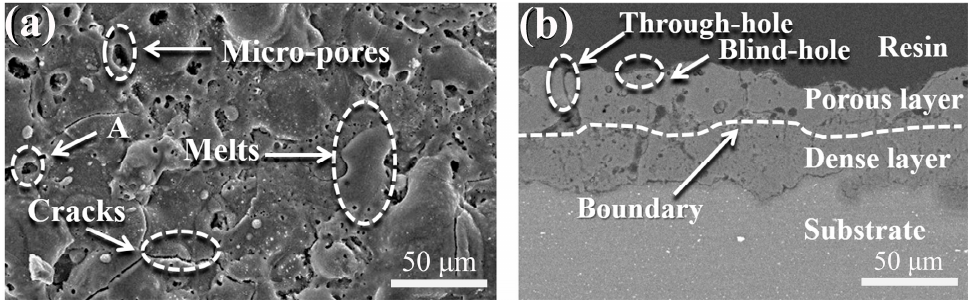
Figure 1. ( a ) Surface and ( b ) cross-sectional morphologies of micro-arc oxidation (MAO) coating.